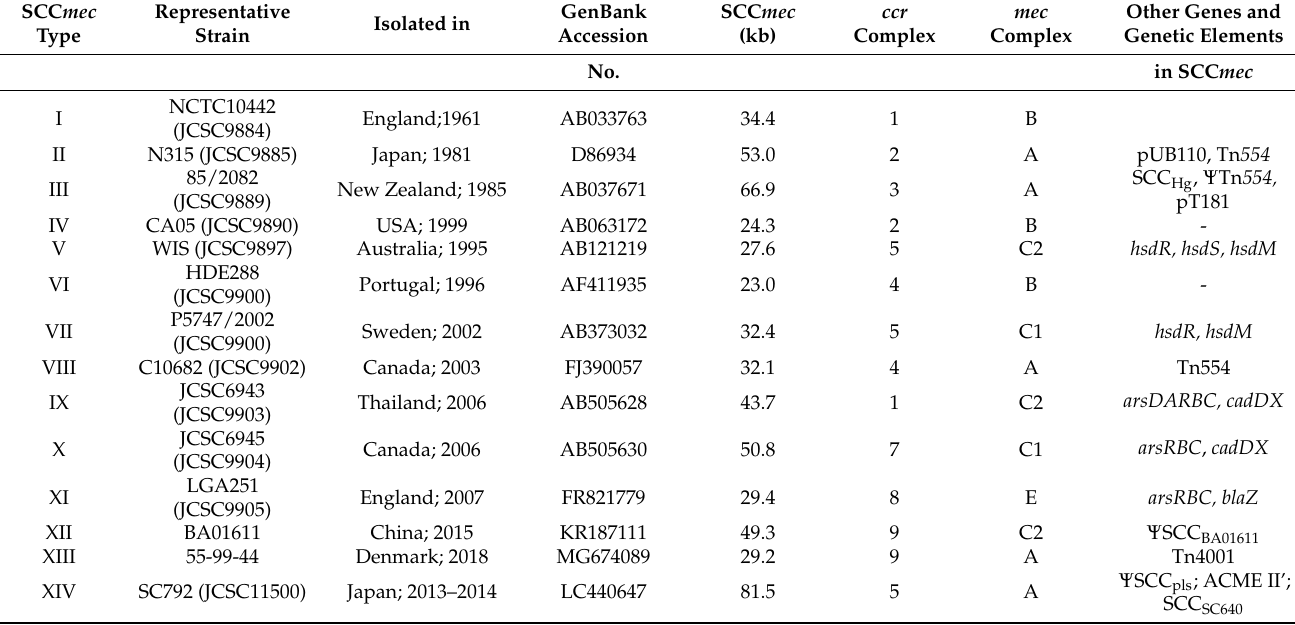
Table 3. Types of SCC mec